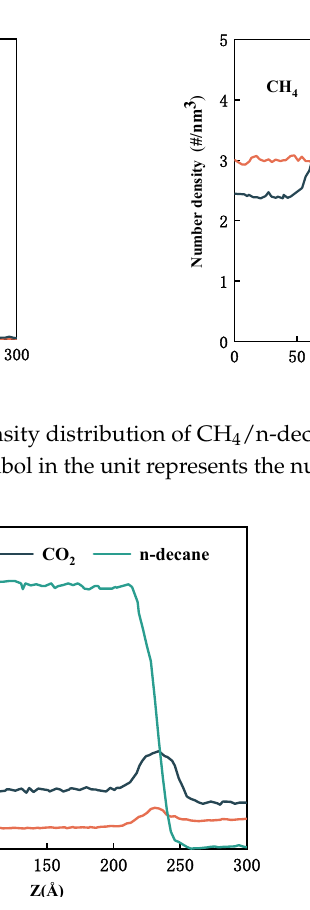
Figure 4. Number density distribution of CH 4 /n-decane at different temperatures at 20.12 MPa. (The # symbol in the unit represents the number of molecules).